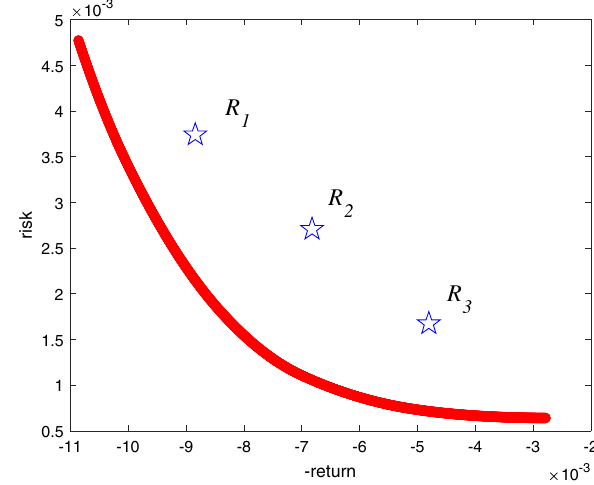
Fig. 10 Different initial reference point in the objective space high risk for getting more money, while pessimistic DMs pay much attention on the instability associated with risk and want to choose a low-risk portfolio. Besides, there is a type of DMs endorsing moderate return and moderate